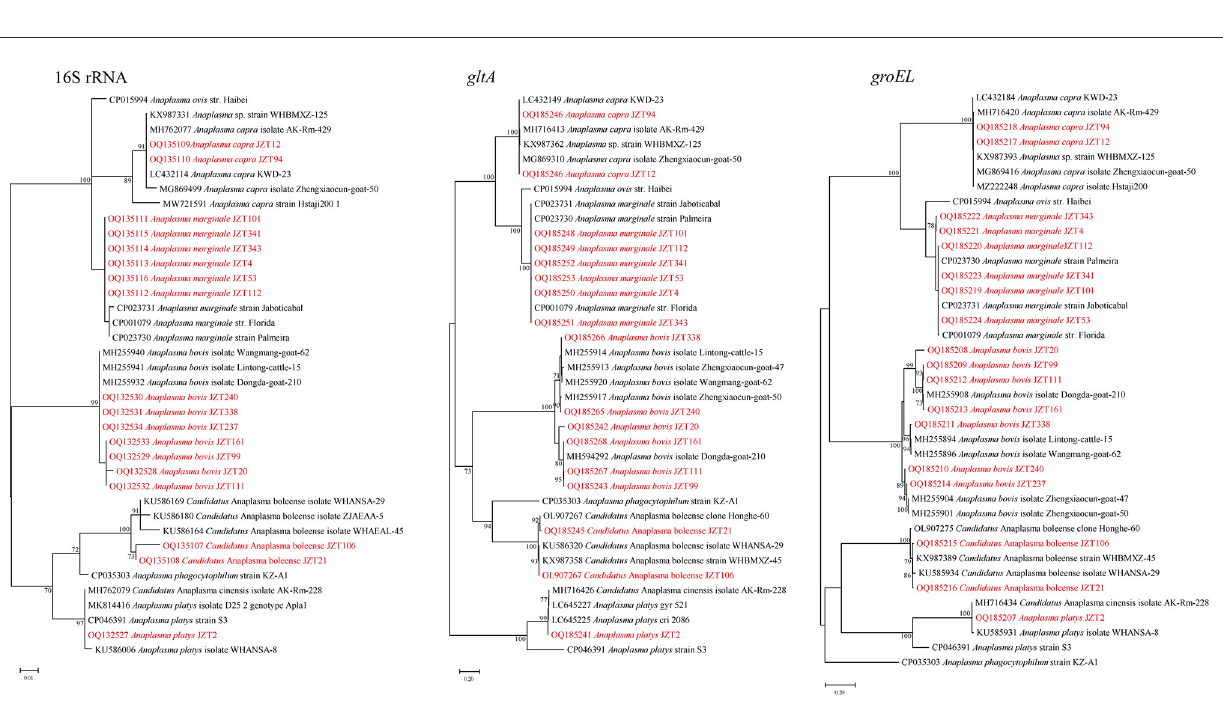
FIGURE4 Phylogenetic trees constructed using PhyML 3.0 based on the nucleotide sequences of the 16S rRNA (837–1,234 bp), gltA (711–1,102 bp), and groEL (822–1,371 bp) genes of Anaplasma strains. Sequences obtained in this study are marked in red.